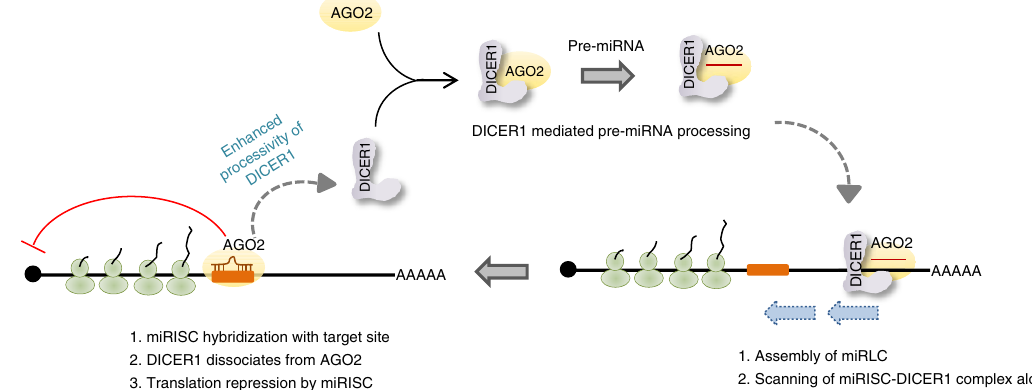
Figure 7 | A model of target-driven miRNA biogenesis. Schematic model of target mRNA-driven miRNA biogenesis. Immediately after pre-miRNA processing and AGO2 loading, DICER1 remains associated with AGO2. Newly formed miRISC/DICER1 complex scans the 3 0 -UTR of a mRNA in search of cognate miRNA-binding site. On target site finding and miRNA–mRNA hybrid formation, DICER1 dissociates from AGO2 and binds free AGO2 to catalyse another round of pre-miRNA processing and miRNP formation. The presence of the target sites increases the ‘processivity’ of DICER1, leading to enhanced miRNA biogenesis from precursor per unit